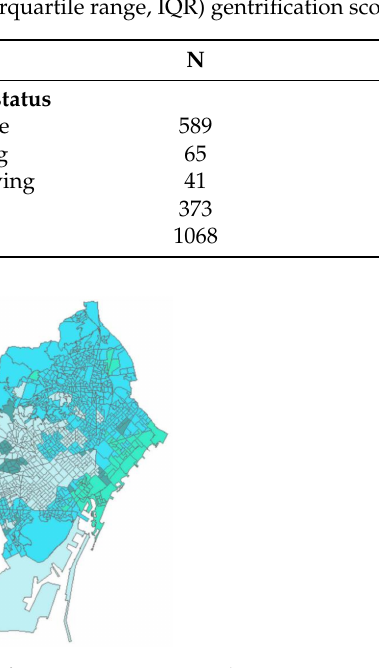
Figure A1. Gentrification status in Barcelona in